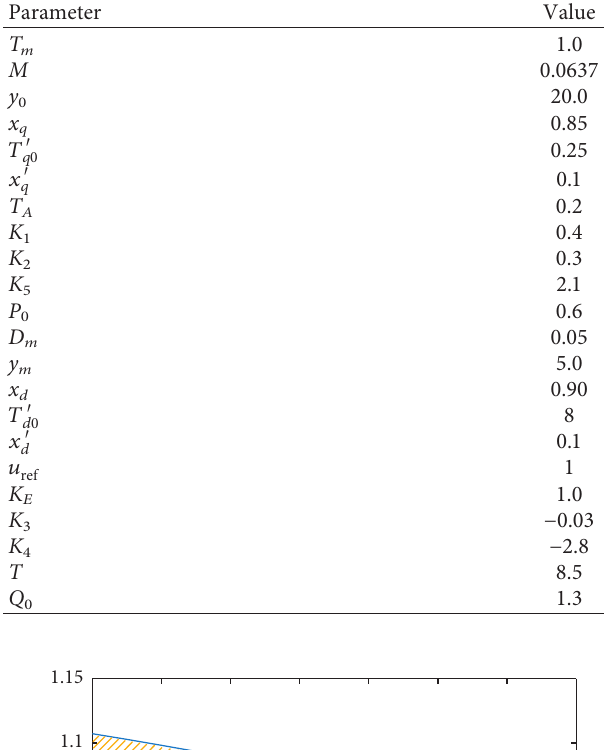
Table 1: Parameter of the equivalent system and load model.